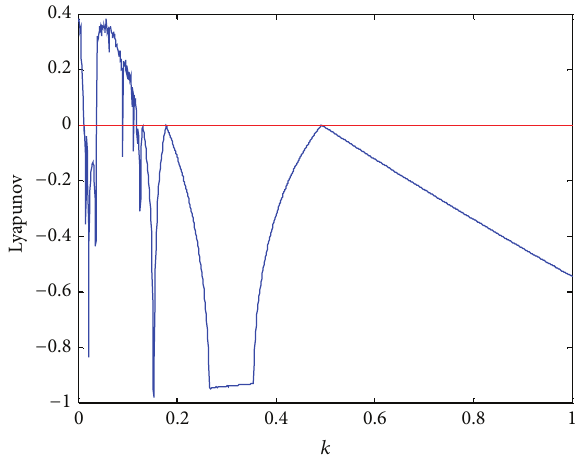
Figure 6: The maximal Lyapunov exponents diagram before and after the system is controlled with the controlling factor 𝑘 = 0.2 .